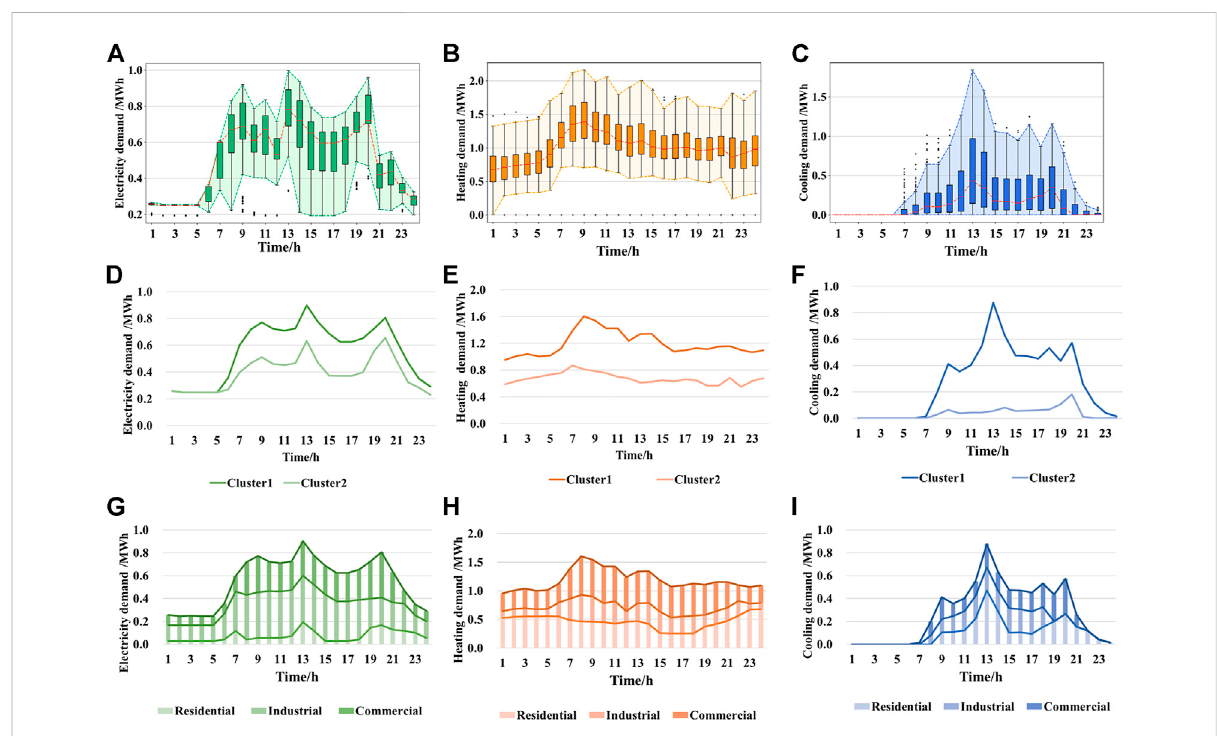
FIGURE 6 Plot of the forecasted energy demand. Figure (A – C) show the annual statistics of hourly electricity, heating, and cooling demand. Hourly electricity demand in the transition season, heating demand in winter, and cooling demand in summer for the typical days are shown in (D – F) , respectively. Typical hourly electricity, heating, and cooling demand for cluster one in each region are shown in (G – I) .